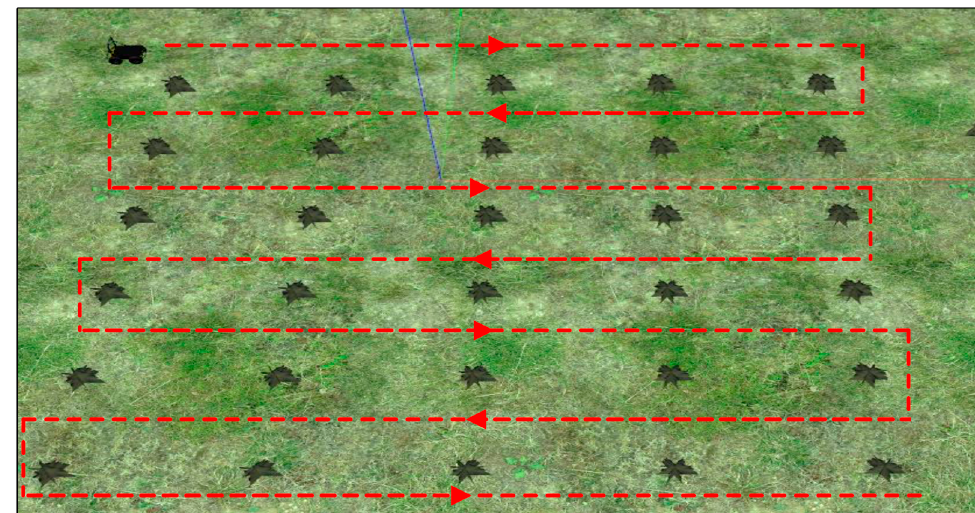
Figure 8. Deterministic area coverage implemented in AgROS.